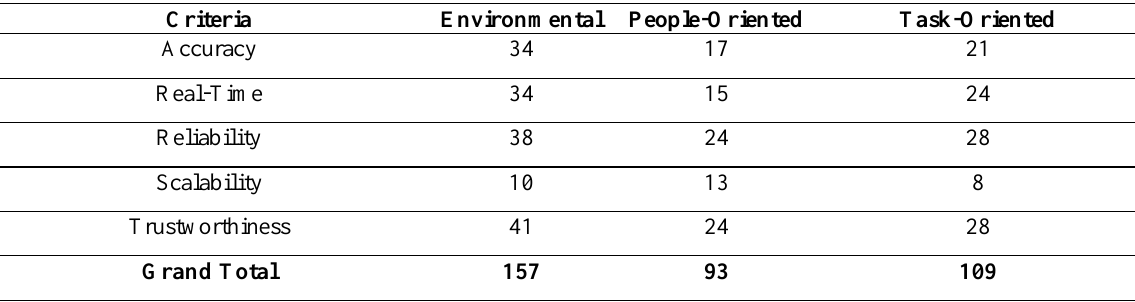
Table 6. General evaluation of Participatory Sensing